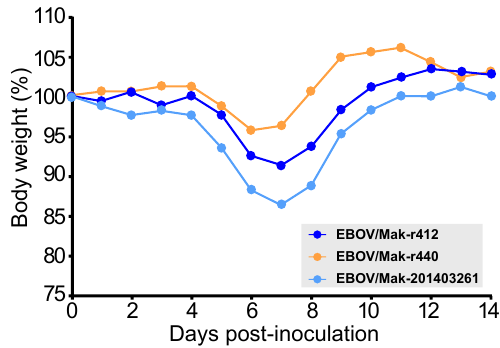
Figure 6. Recombinant EBOV/Mak-G3864.1 mutant r412 caused increased weight loss than r440 in INFAR − / − mice. INFAR − / − laboratory mice were infected with ≈ 1000 PFU of rEBOV/Mak-G3864.1 mutants r412 (GP 1,2 82V) or r440 (GP 1,2 82A) or the natural isolate EBOV Mak-201403261. Weights were monitored daily for 14 d. INFAR − / − = interferon-alpha/beta receptor